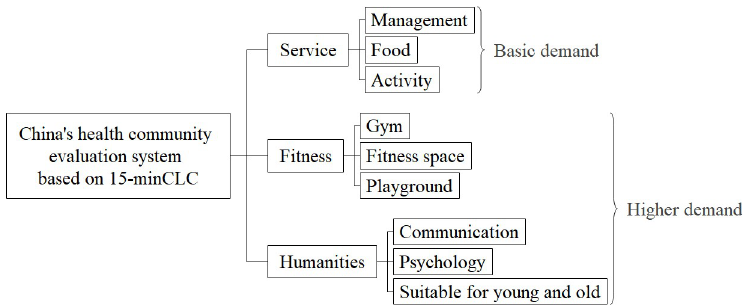
Fig 7. China’s health community evaluation system based on